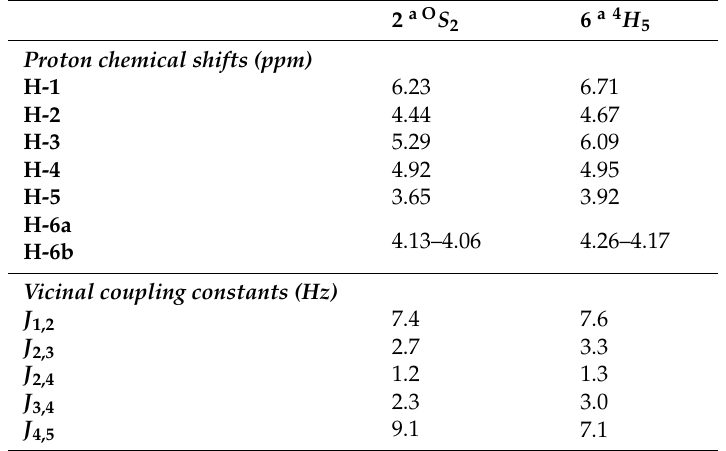
Table 1. 1 H-NMR comparison between uncomplexed ligand 2 and Pd complex 6 .